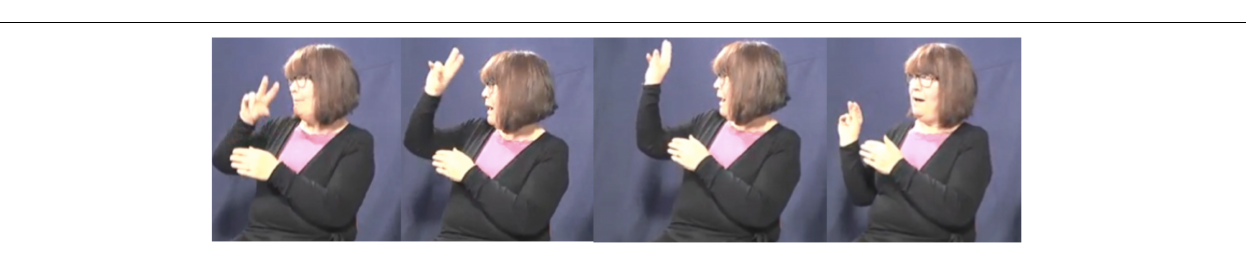
FIGURE 8 | Fully-lexical sign MOON which is modified in order to indicate and depict its location, as produced in example 2. Figure reproduced with permission from Corpus VGT (Van Herreweghe et al.,